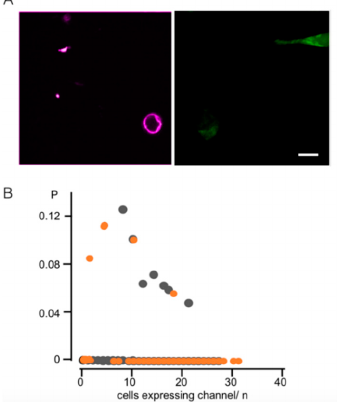
Figure 8. Active Kmpv 12T channel does not trigger apoptosis: ( A ) Fluorescent images of HEK293 cells; apoptotic cells are identified by Annexin V Alexa 457 (purple channel, left image) and cells expressing Kmpv 12T by GFP fluorescence (green channel, right image). The channel expressing cells are not apoptotic. Scale bar 10 μ m. ( B ) Probability of finding an AnnexinV positive signal in a cell as a function of the number of HEK293 cells transfected with [ Kmpv 12T /CRY2/CIB1 ] (orange) or [ Kesv/CRY2/CIB1 ] (gray) in the optical window. This analysis was performed on 400 coverslips with >4000 cells for each channel. Cells were incubated for 16 h and illuminated with a single 1-min light pulse of 6 μ mol 4 h prior to imaging.